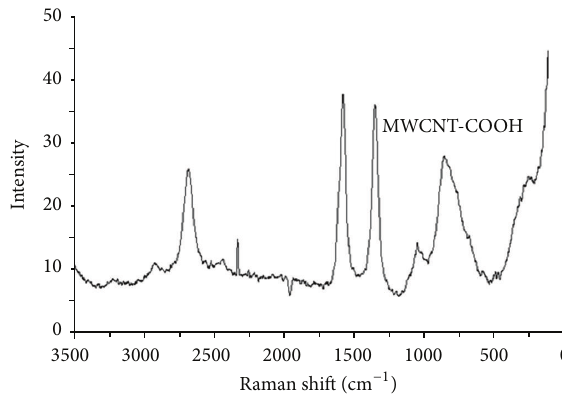
Figure 5: Raman spectra of MWCNT-COOH.